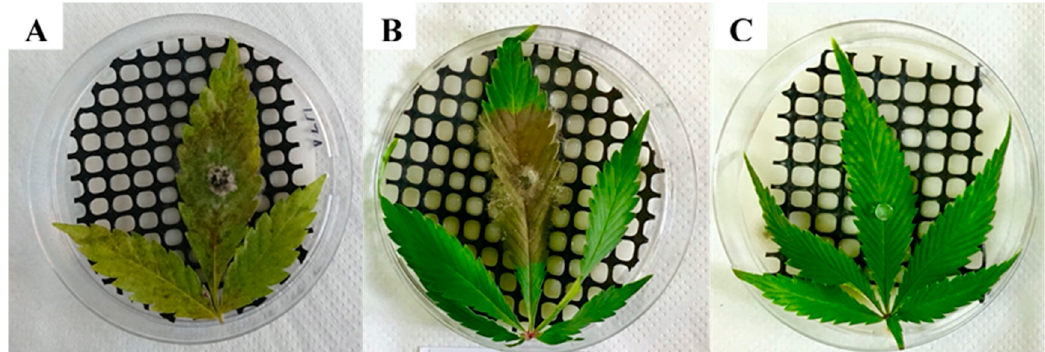
Figure 3. Koch postulate assays on detached MC leaves, inoculated using a PDAC plug, of ( A ) Alternaria alternata (isolate 22A); ( B ) Botrytis cinerea (isolate 63A); and ( C ) control leaves, inoculated with a sterile PDAC plug.